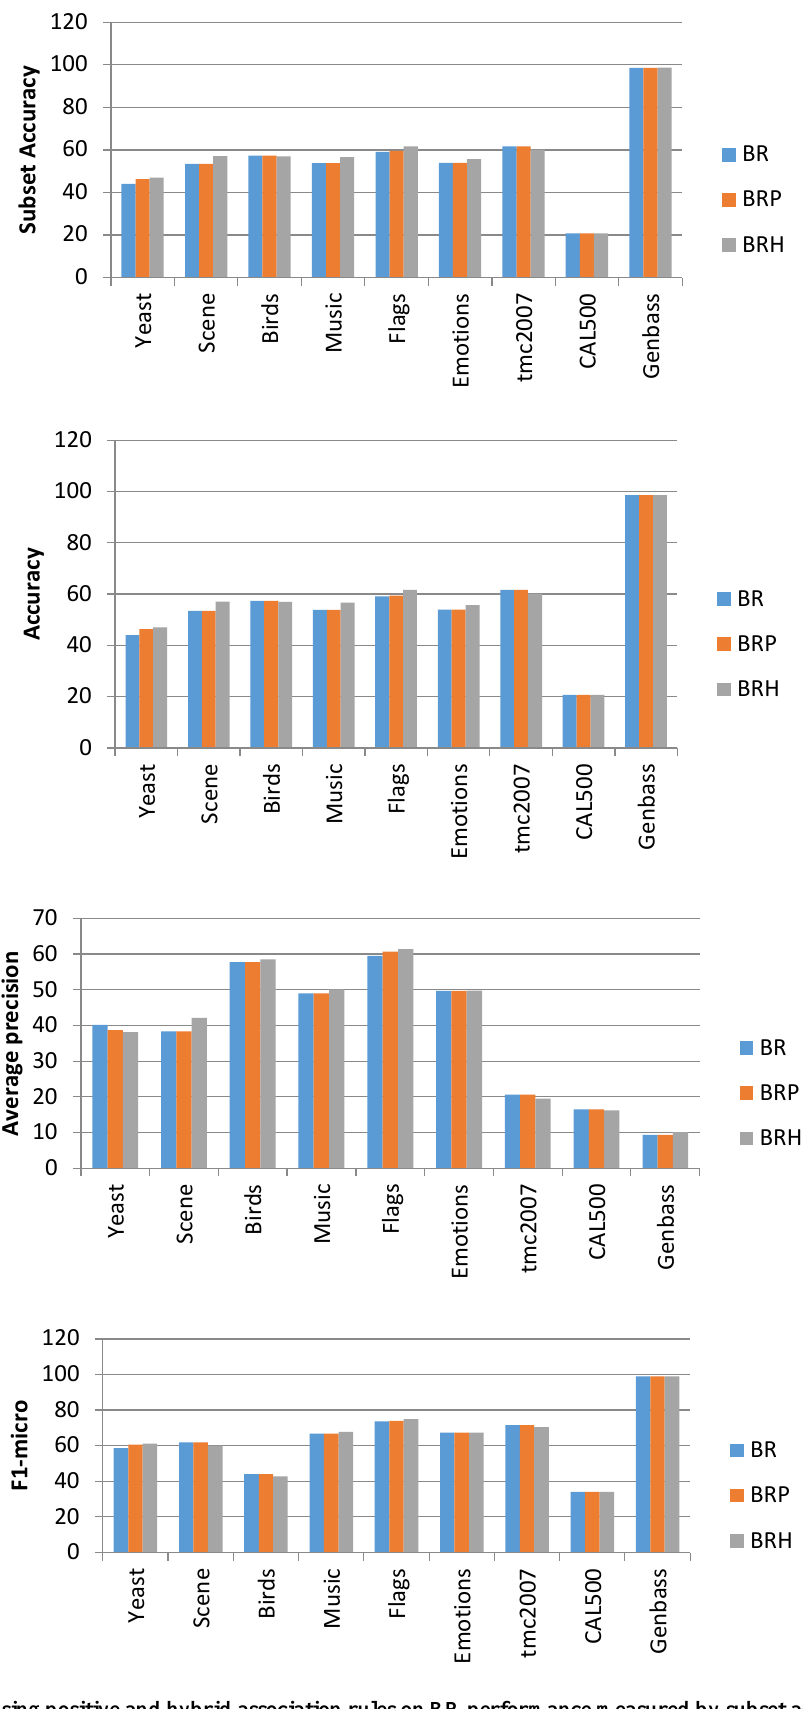
Figure 2. Effect of using positive and hybrid association rules on BR performance measured by subset accuracy, accuracy, average precision, and F1-micro. Bigger values represent a better